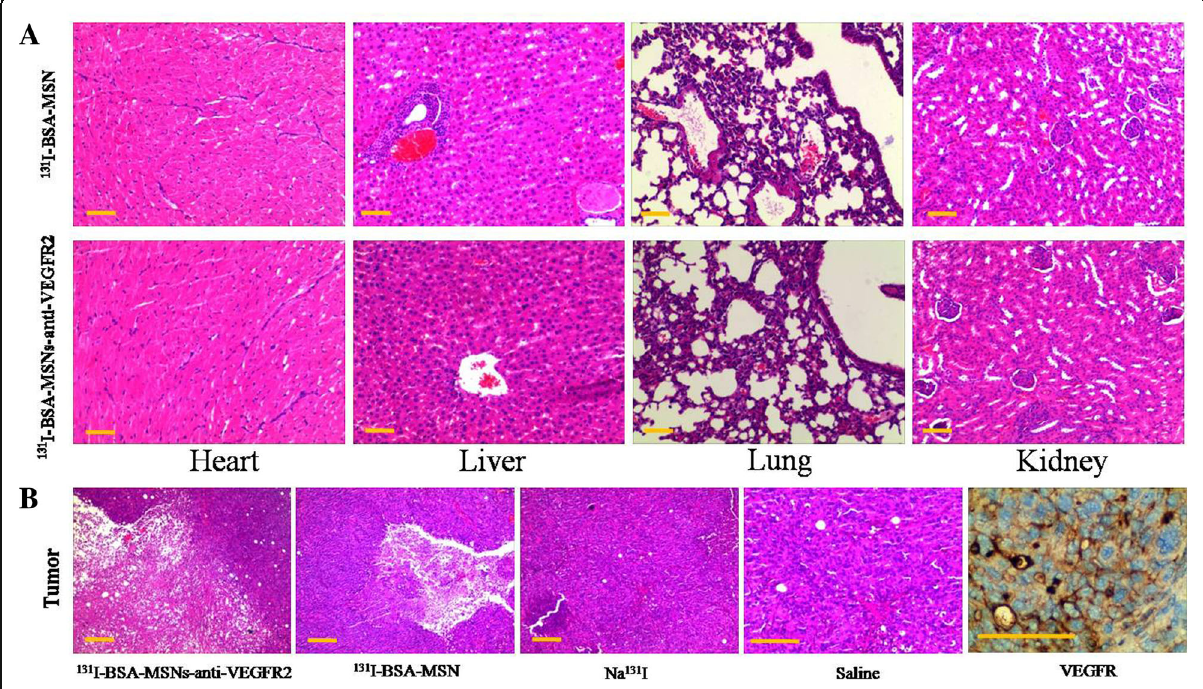
Fig. 5 Histopathological analysis. a Histopathologic analysis of major organs of FRO ATC tumor-bearing mice after treatment with 131 I-labeled nanoparticles. No significant pathological changes in the heart, liver, lung, and kidney were observed. b Pathologic examinations (H &E staining) and immunohistochemical analysis of tumors in mice. Large fragments from the degeneration and necrosis of tumor cells in the anti-VEGFR2- targeted group and small pieces of low density necrosis in the 131 I-BSA-MSNs group are displayed. By contrast, only viable tumor cells were observed in the Na 131 I and saline groups. Photomicrograph from immunohistochemical analysis showed visible expression of VEGFR. Bar = 200 μ